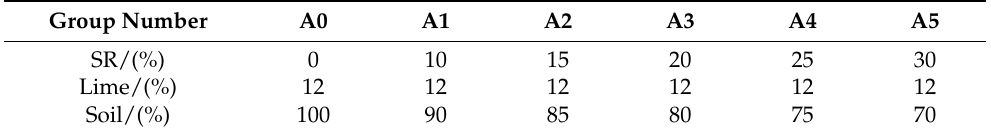
Table 2. Test matching